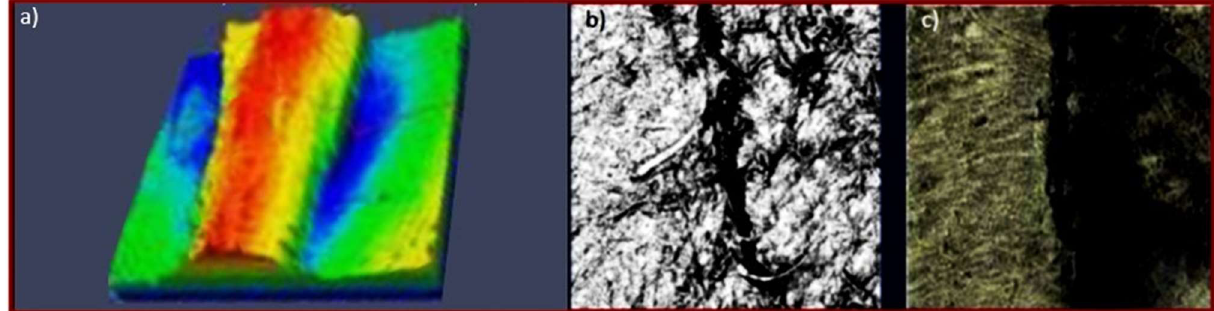
Figure 17. View in a confocal laser microscope of a tooth fracture after filling the root canal: ( a ) an exposed cylindrical stud with slight differences in geometrical features after filling with gutta-percha using the thermoplastic method (20×); ( b ) leakage of the connection between the filling using the thermoplastic method with a filling material based on polymeric Resilon-type materials with dentin of the root canal (2000×); ( c ) clear longitudinal leakage of the connection between the filling and the root dentine, with the method of filling and obturation as in ( b ) (2000×).